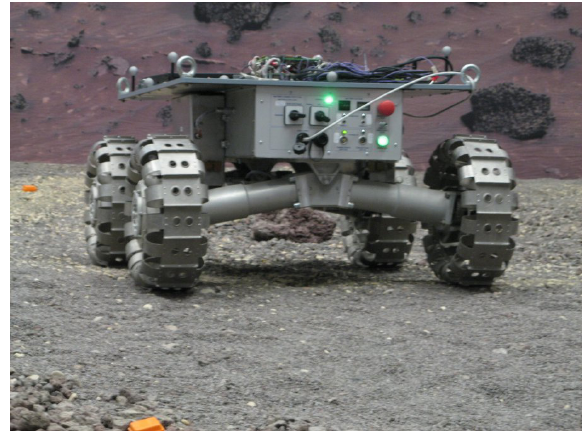
Figure 8. Lunar Rover Model (LRM) rover of ESA while performing a test in the